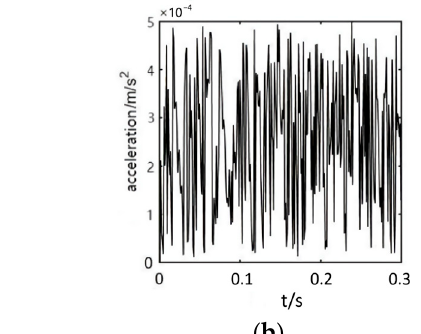
Figure 3. Anchor damage overall model diagram.